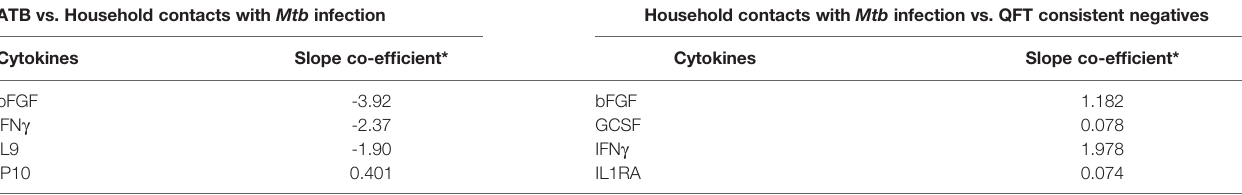
TABLE 3A | Expression and regression coef fi cients for each biomarker of the identi fi ed protein signature. ATB vs. Household contacts with Mtb